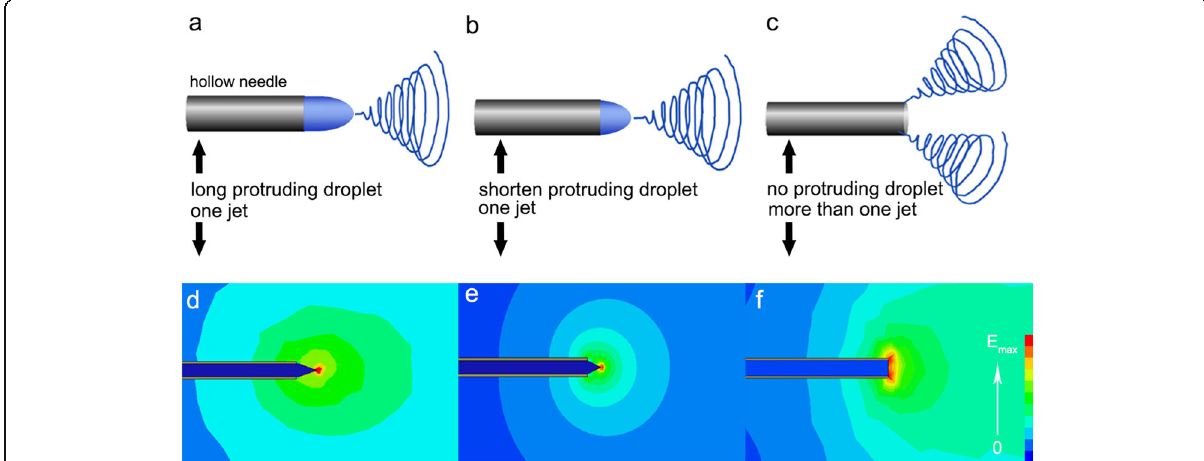
Fig. 1 a – f The schematic diagram of the jet evolution and the electrical field distribution at three protruding droplet lengths (long protruding droplet, short protruding droplet, no protruding droplet)